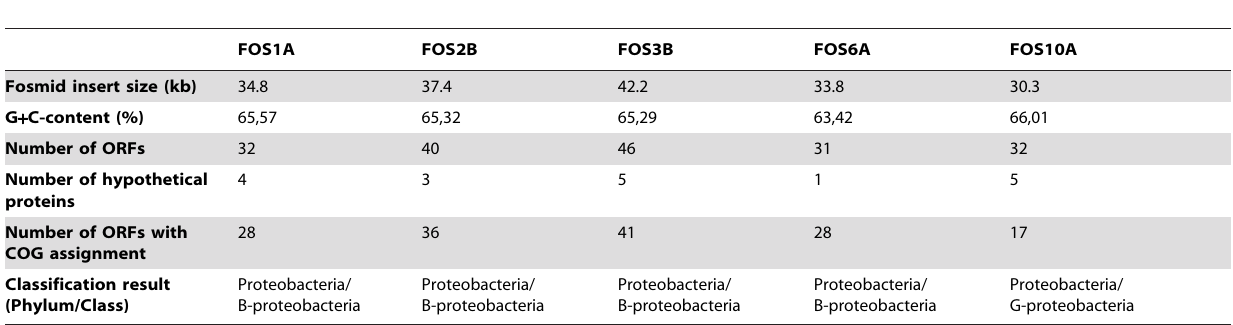
Table 2. Characterization of the fosmid inserts of the metagenomic clones: insert size, G + C content and number of ORFs.